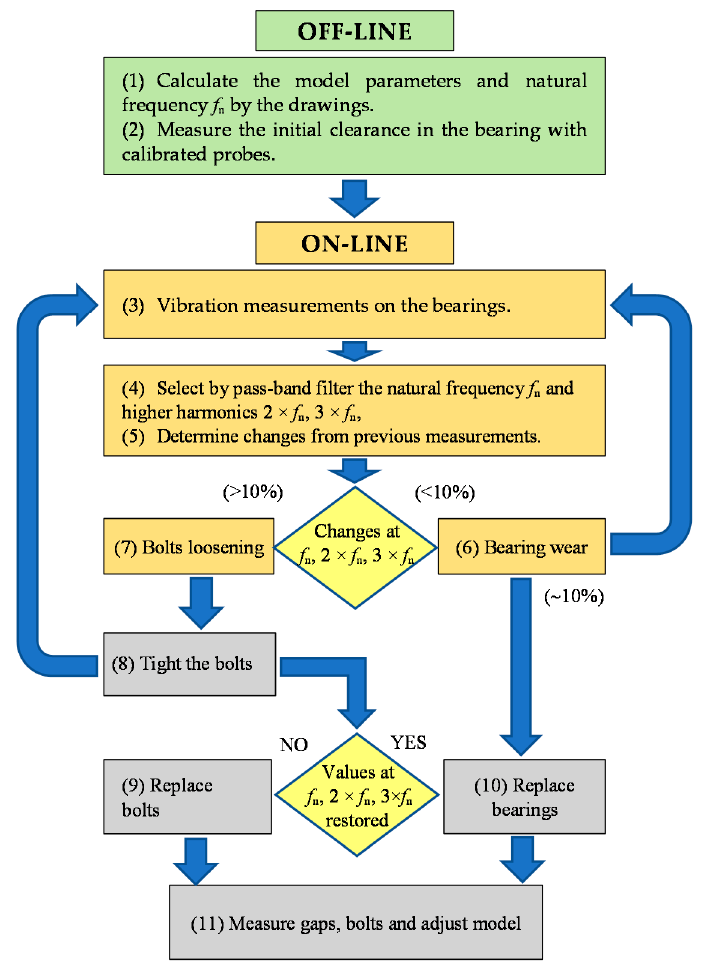
Figure 4. Algorithm of radial clearances and bolts loosening diagnostics.